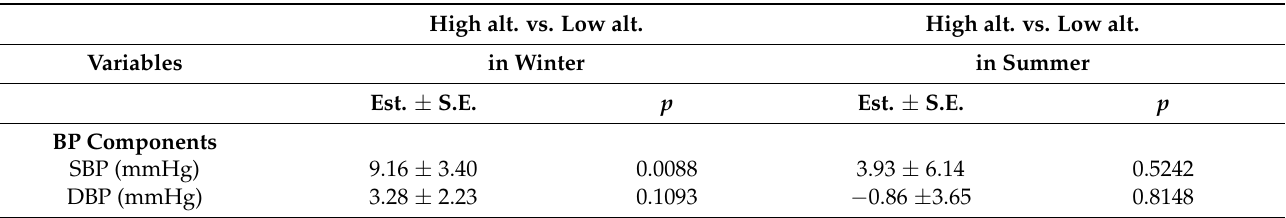
In Table 6, the mixed effects model showed the health effects of high vs. low altitude on CVFs and SpO 2 concentration in winter and summer. After controlling for seasons, altitudes, age, gender, BMI, hypertension, habits of smoking and alcohol, and hypercholes- terolemia, the effects of high altitude vs. low altitude on CVFs in winter are as follows: increased 9.2, and 3.3 mmHg in the SBP and DBP, respectively, increased 7.6, and 2.7 mmHg in the cSBP and cDBP, respectively; and increased 16.5 beats/min, and 1.4 L/m in the HR and CO, respectively. The SpO 2 concentration significantly decreased by − 8.3 ± 1.47% at high and low altitude in winter. There were no statistical significant differences between high altitude and low altitude in summer, with the exception of HR and CO, which showed significant increase (9.5 ± 4.24% beats/min and 1.3 ± 0.46% L/min, respectively); the SpO 2 concentration significantly decrease by − 7.9 ± 2.84%. Table 6. Generalized linear mixed-effect models for determinants of seasonal variations on blood pressure and cardiovascu- lar function. High alt. vs. Low alt. High alt. vs. Low alt. Variables in Winter in Summer Est. ± S.E. Est. ±